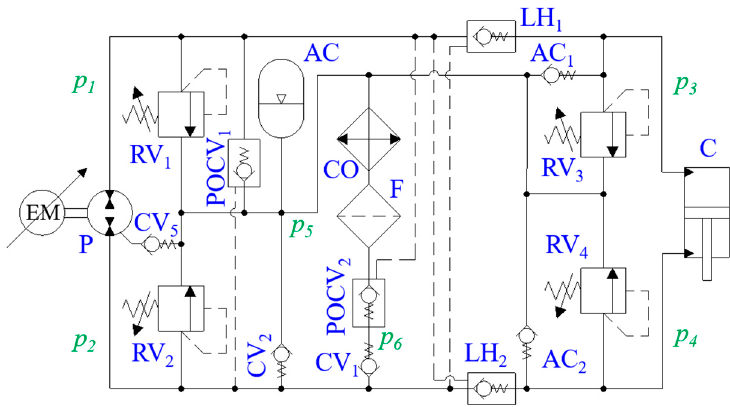
Figure 15. Alternative system with the load-holding valves arranged according to References [47–49].